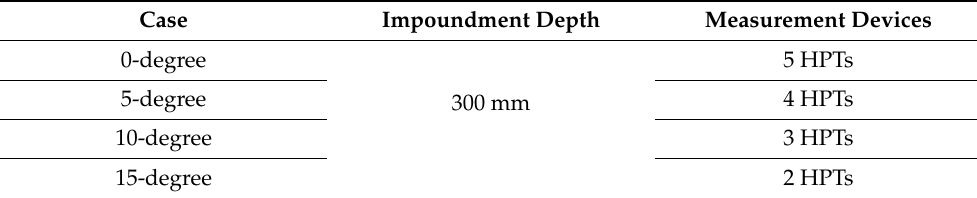
Table 1. Experimental